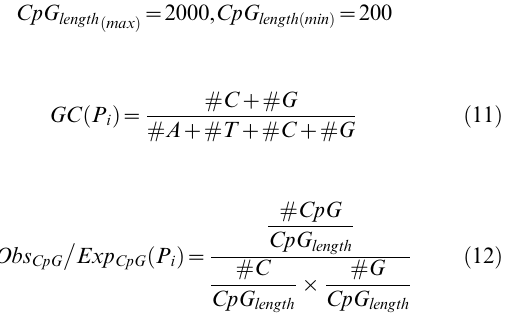
Figure S3 Bar graphs illustrating the different sensitivities for each method on chromosomes 21 and chromosome 22 contigs. Figure S4 ROC curves plotted for all methods to evaluate the data sets. (DOC) Figure S5 Distribution of CpG islands in the entire human genome. The blue dots indicate the CpG islands, and the x and y axes are the GC% and the CpGs o/e ratio, respectively. Most CpG islands lie in the region of 50–70% GC, and an o/e ratio of between 0.6 and 1.0. Figure S6 Analysis of predicted CpG islands by CPSORL in the entire human genome. Figure S7 Illustration of calculating methylation densities. Figure S8 Length distribution of CPSORL and other methods in the human genome. Figure S9 A description of the step-by-step procedures for the algorithm. (DOC) Text S1 The pseudo-codes for PSO and CPSO. Table S1 Comparison of different CpG island prediction tools for contig